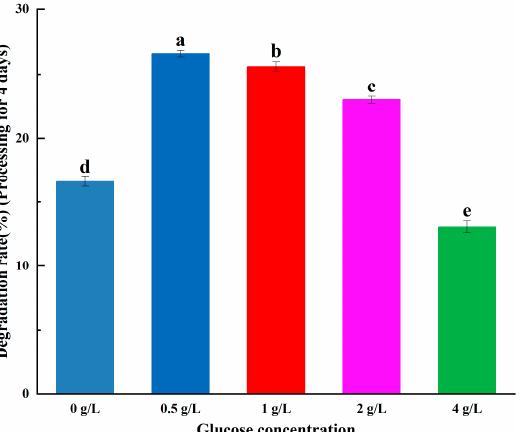
Figure 3. Abamectin degradation at different glucose concentrations. Error bars represent the stand- ard deviation of three replicate experiments, and different letters indicate significant differences as determined by Waller-Duncan’s test ( P < 0.05).